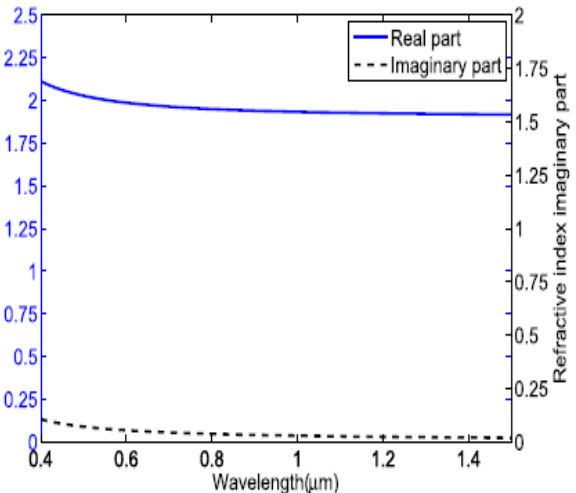
Figure 13. Dispersion curves for TiO 2 /PSS. Reprinted with permission from [119], copyright The Optical Society.